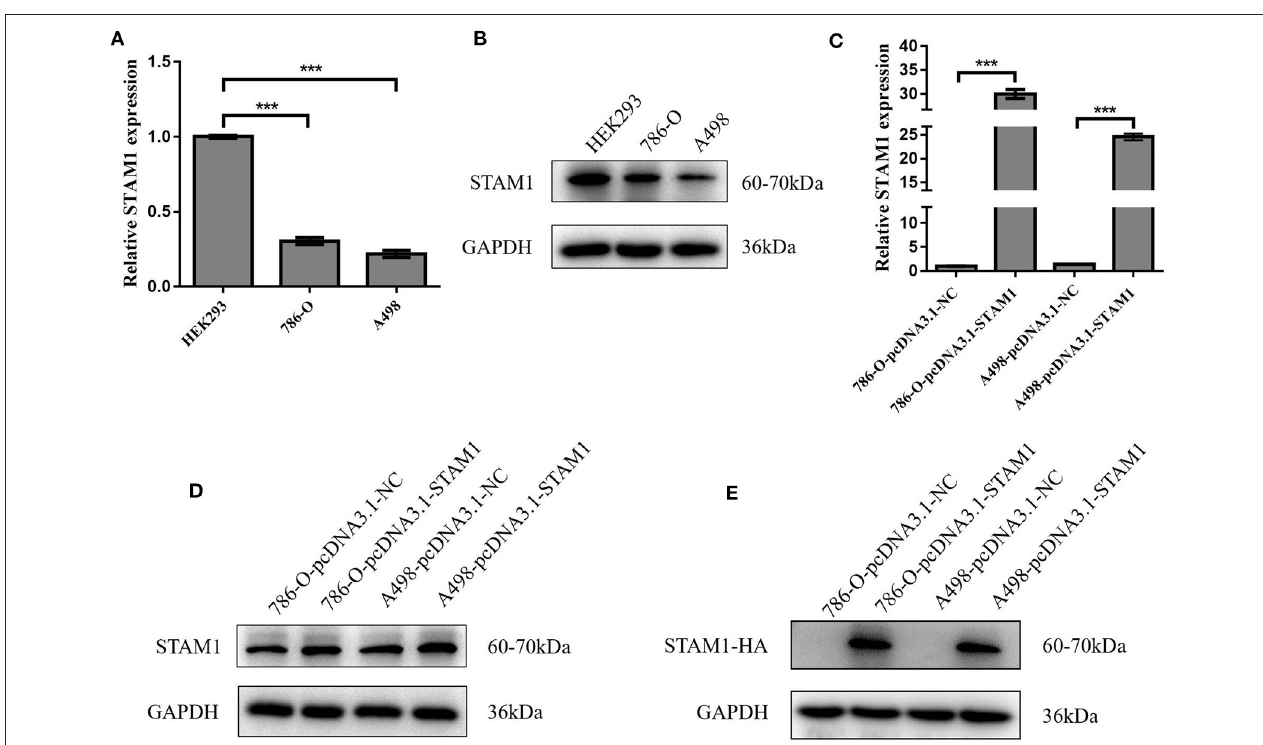
FIGURE 5 | mRNA and protein expression of STAM1 in normal kidney cell and clear cell renal cell carcinoma (ccRCC) cell lines and the verification of STAM1 overexpression in ccRCC cell lines. Comparison of mRNA (A) and protein (B) expression of STAM1 in HEK293, 786-O, and A498 cells. Verification of STAM1 overexpression in mRNA (C) and protein (D,E) levels in 786-O and A498 cells. *** p < 0.001.